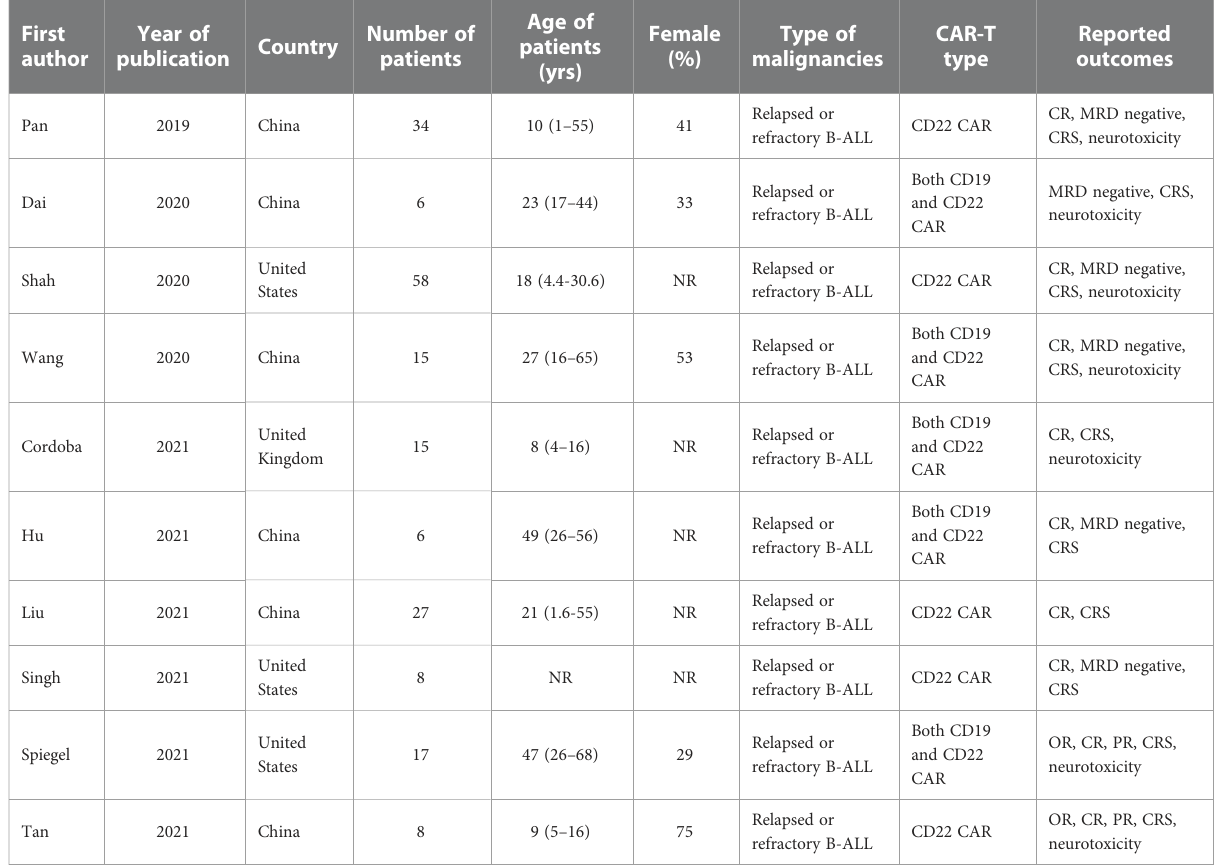
TABLE 1 Characteristics of included